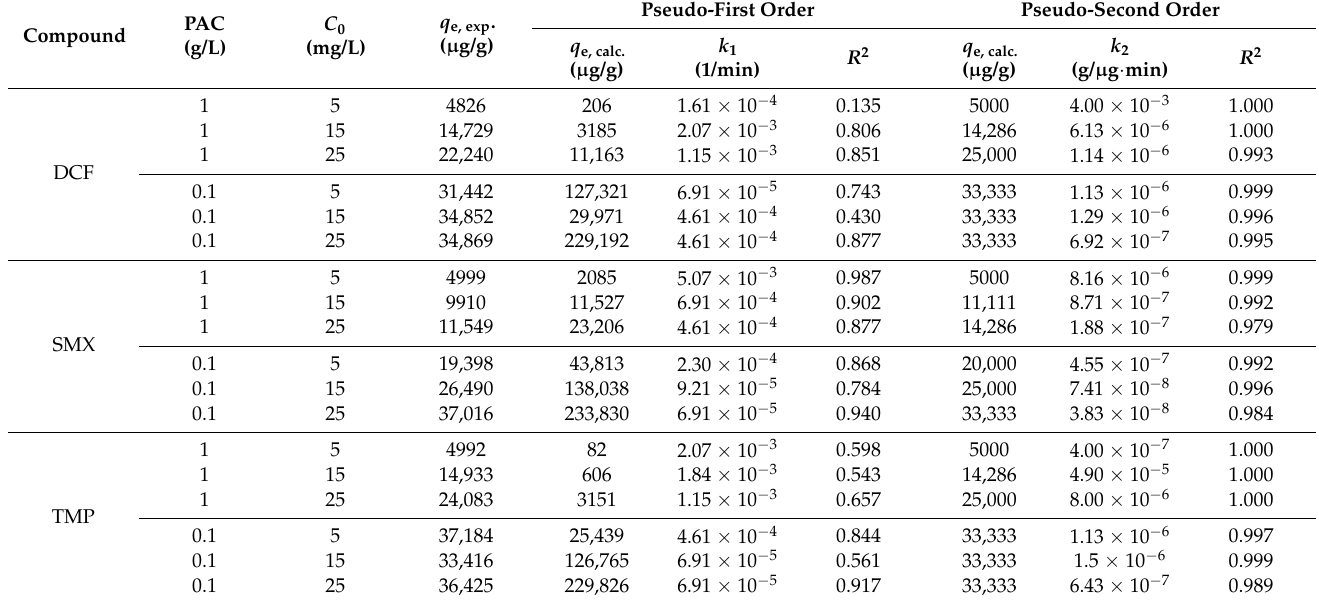
Table 1. Sorption kinetic parameters of DCF, SMX and TMP in ultra-pure water with 1 g/L and 0.1 g/L of added PAC. C 0 indicates the initial concentration of the pharmaceutical, and q e, exp. indi- cates the values of q e obtained